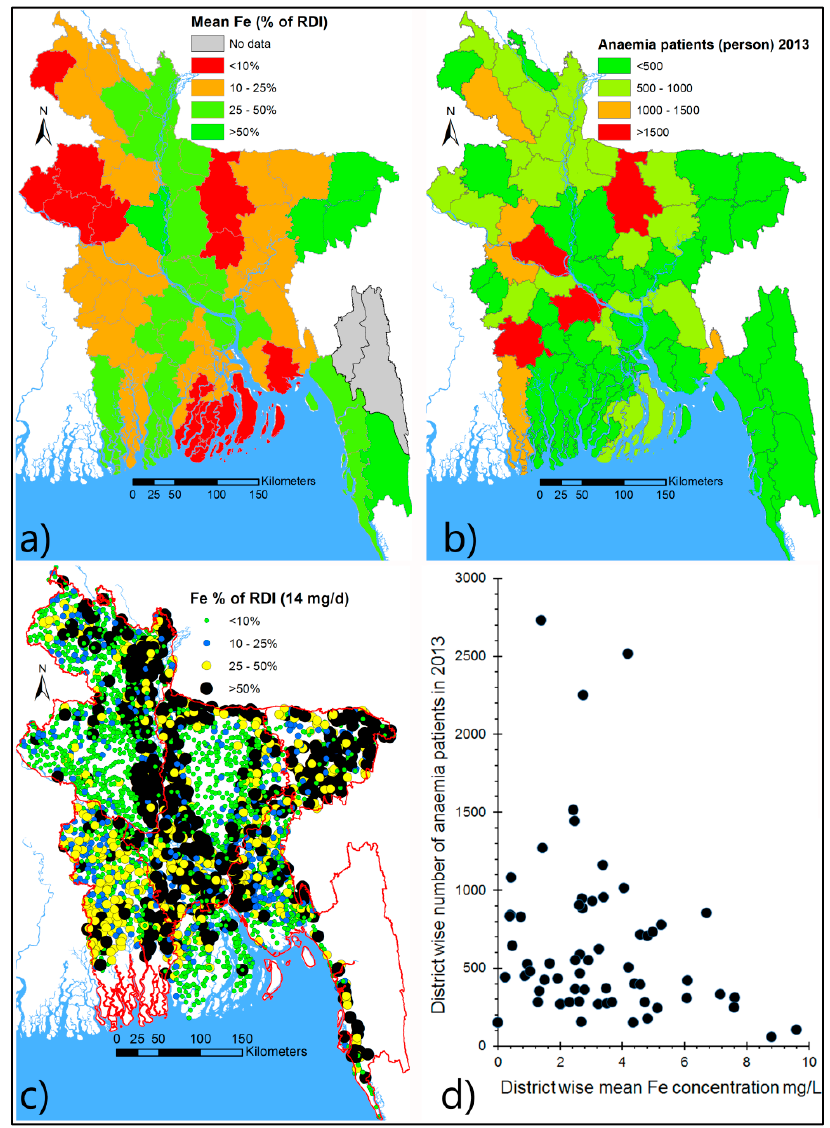
Figure 10. Possible inverse relationship between Fe concentration in tubewell water and anaemia in Bangladesh. ( a ) District based mean Fe concentration [22] in relation to RDI; ( b ) district based anaemia patients attended in hospital in 2013,see text for data source; ( c ) spatial variation of well-water Fe in Bangladesh; ( d ) scatter plot of district based mean Fe (panel— a ) concentration and district based number of anaemia patients (panel— b ) in 2013.